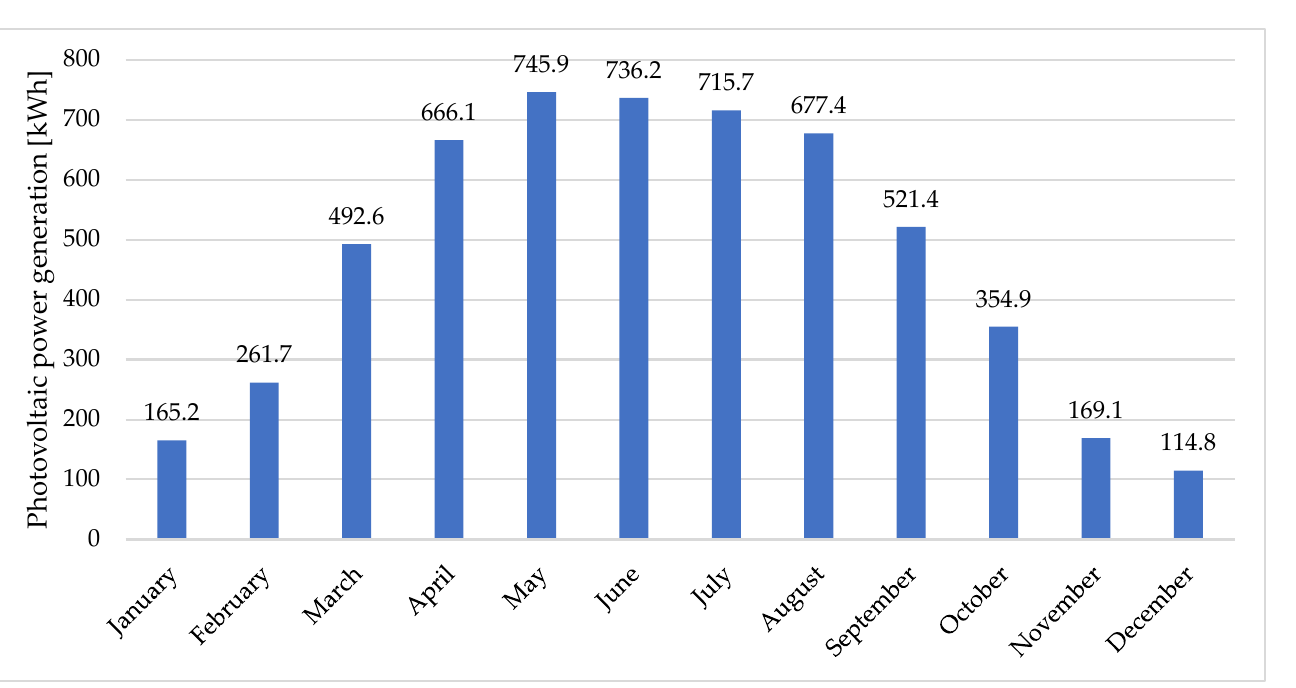
Figure 3. Distribution of the arithmetic mean annual production of electricity from the designed PV system for the indicated location based on data presented in the PV SOL software and on the Global Solar Atlas website [42].